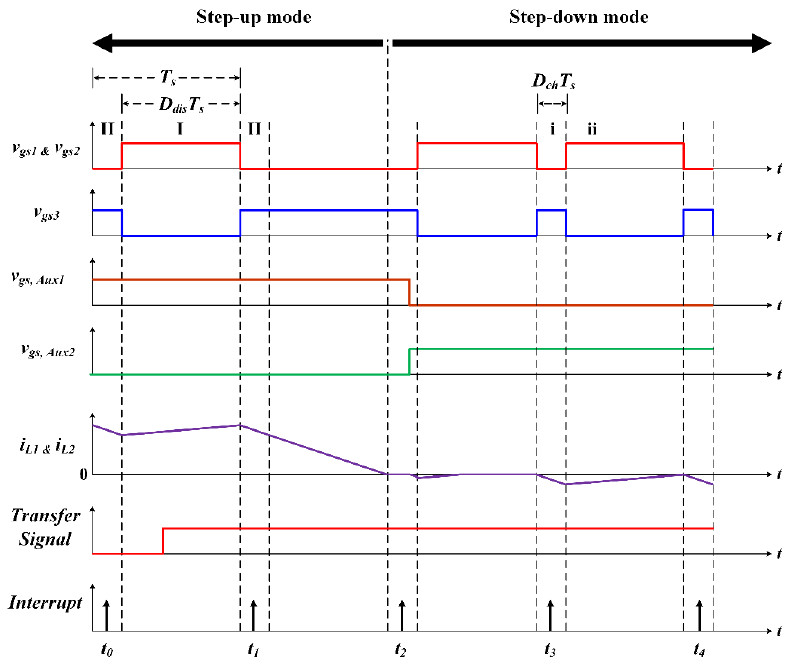
Figure 9. The timing of the transferring state from step-up mode to step-down mode.